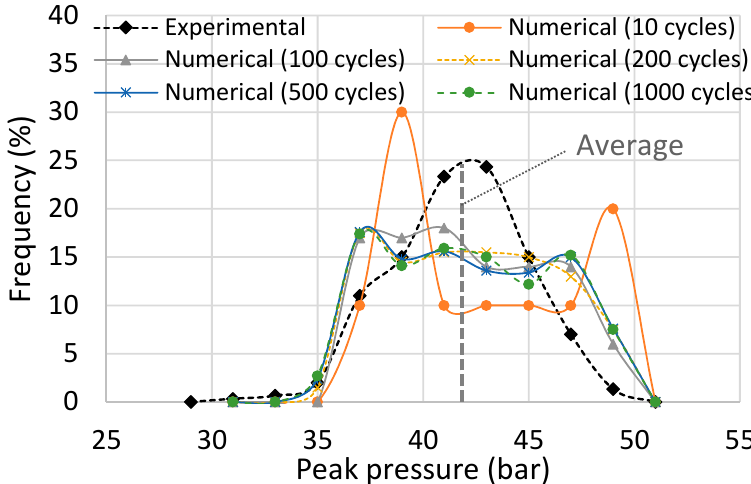
Figure 5. Frequency of peak pressure for a different number of cycles and comparison with the measured one.